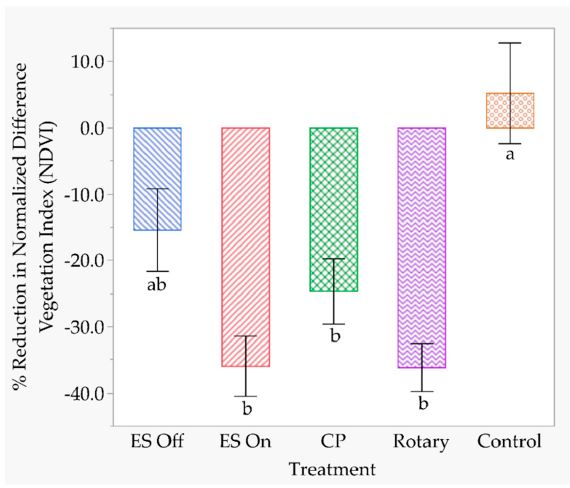
Figure 10. The percent change in NDVI (±SEM) obtained by ground-based remote sensing. Bar means followed by the same lowercase letter are not significantly different ( p < 0.05) according to Tukey’s HSD test. The treatments described on the X -axis are electrostatically charged off (ES Off) and charged on (ES On) nozzles, the conventional hydraulic (CP) nozzle, and the rotary atomizer (Rotary) nozzle, compared with the Control.